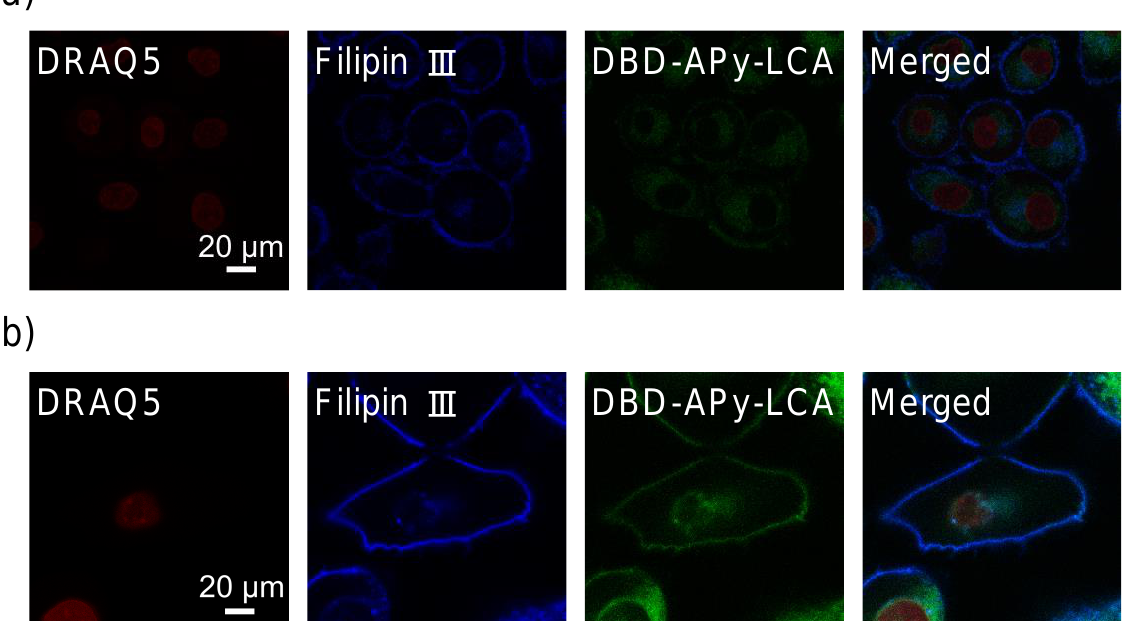
Figure 3. Confocal laser fluorescence microscopy images of ( a ) Hep G2 and ( b ) HeLa cells treated with DRAQ5 (red), Filipin III (blue), and DBD-APy-LCA (green).